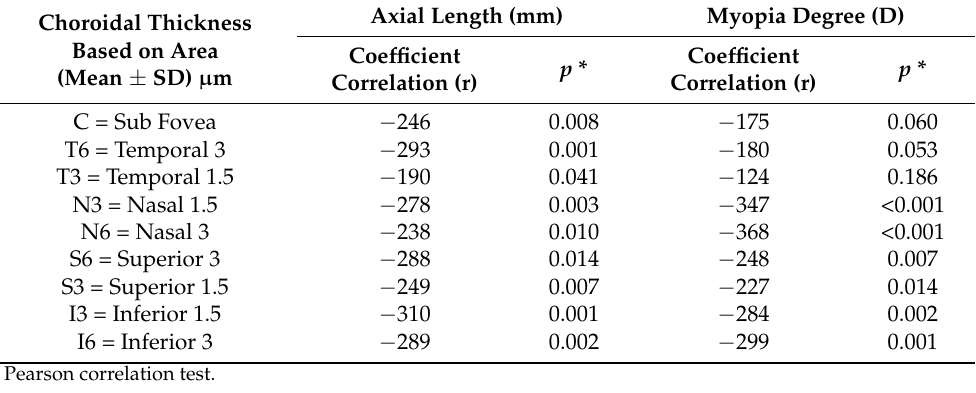
Table 3. Correlation between axial length, degree of myopia, and choroidal thickness in various regions.